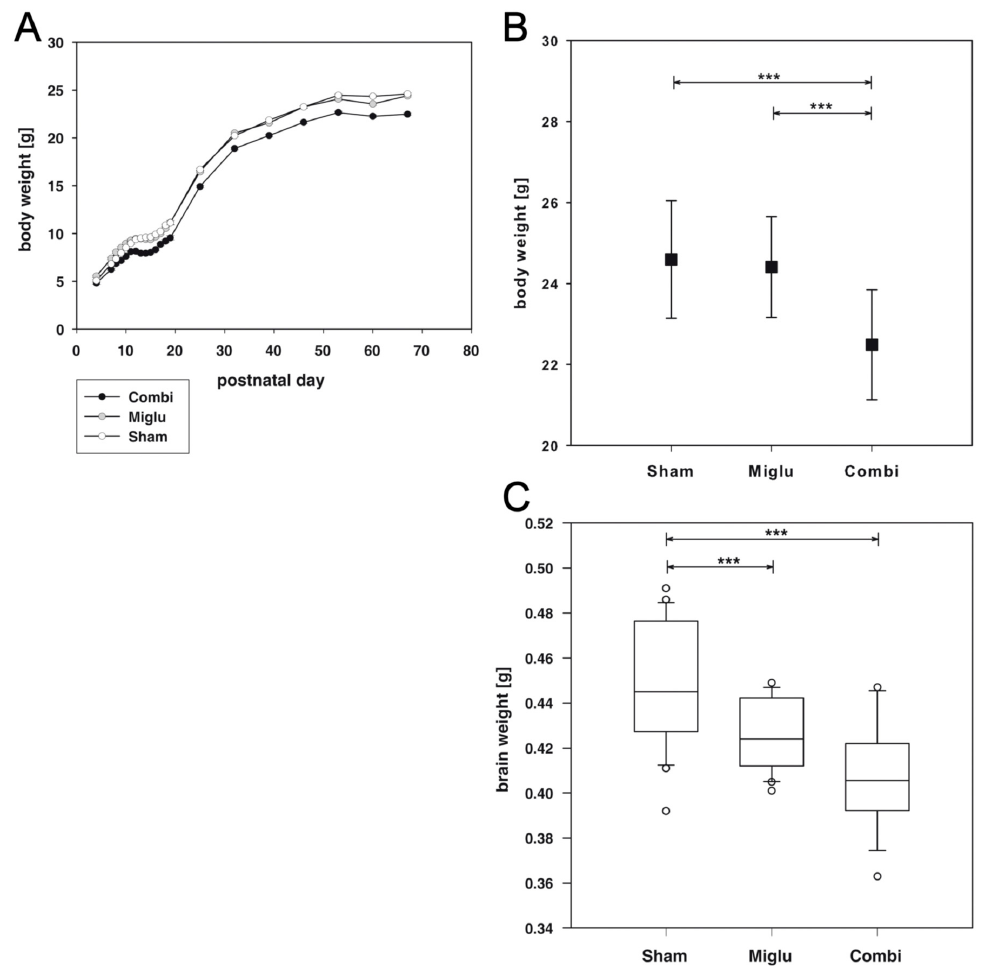
Figure 1. Weights. ( A ) Body weight values of postnatal day 4 to 67 mice. Sham-treated mice ( n = 29) are displayed with open circles, miglu-treated mice ( n = 26) with grey filled circles and combi-treated animals ( n = 26) with black filled circles; ( B ) body weights at day of sacrifice; ( C ) brain weights at day of sacrifice. Scatter plot data are represented as mean ± SD. Box plots depict the groups graphically by displaying the following descriptive statistical parameters: the median, the upper and lower quartiles, and outliers (circles) that lie outside the 10th and 90th percentiles (whiskers). Significant post hoc effects are indicated by asterisks (*** p < 0.001).